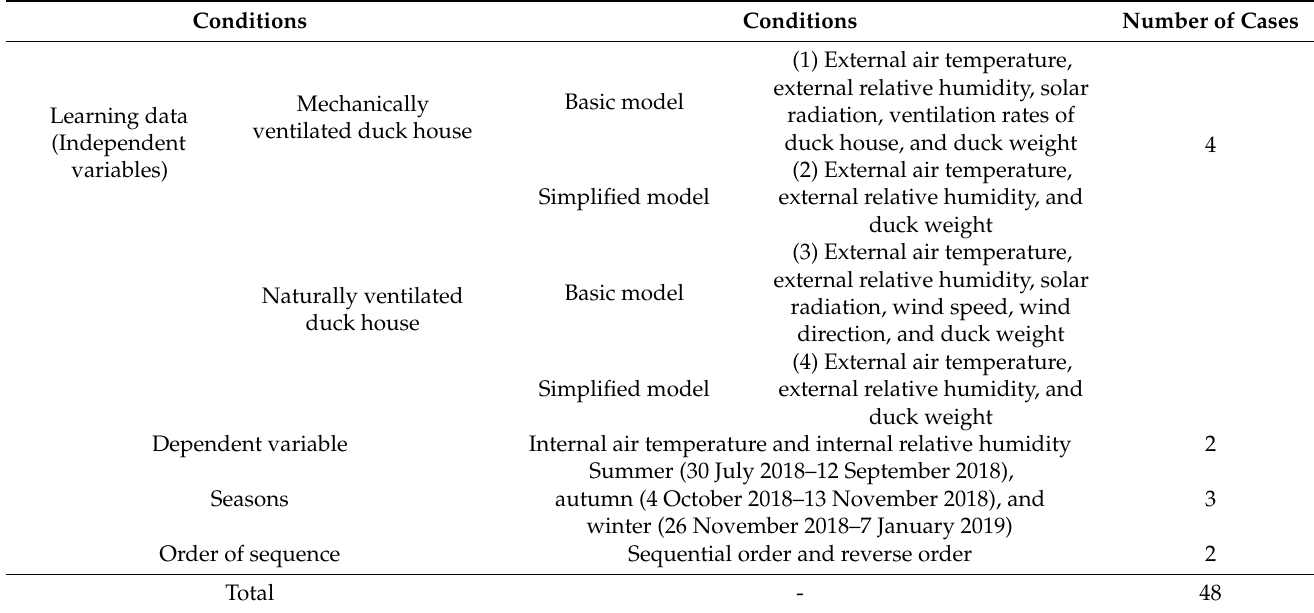
Table 3. Experimental conditions of learning data for developing RNN